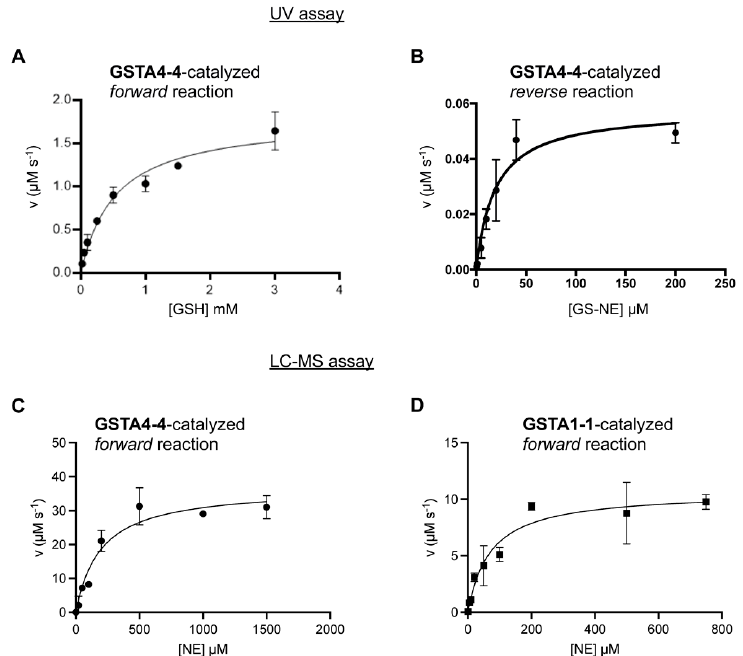
Figure 3. Steady state forward and reverse reactions of GSTA4-4 and forward reaction of GSTA1-1. ( A ): GSTA4-4 activity for the depletion of NE in the ‘forward’ reaction to yield GS-NE, based on the decrease in UV absorbance. ( B ): GSTA4-4 activity in the ‘reverse’ direction to form GSH and NE from GS-NE based on the increase in UV absorbance. ( C ): GSTA4-4 activity in the forward reaction based on LC-MS. ( D ): GSTA1-1 activity in the forward reaction based on LC-MS. Table 1. Kinetic parameters for forward and reverse reactions.